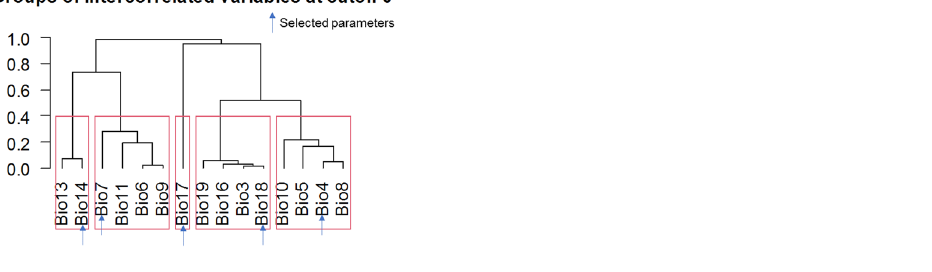
Figure 8. Key model predictor